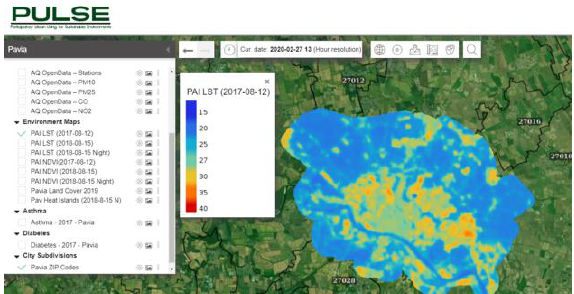
Figure 3. LST map for Pavia on August 8 th , 2017